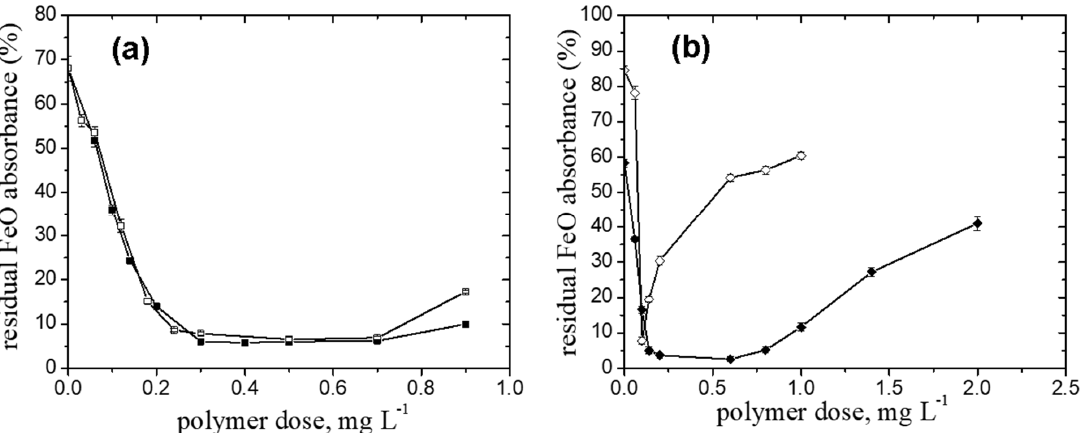
Figure 6. The residual FeO absorbance (%) dependence on the polymer dose: TMAP 0.4 –P for c ip = 0.1 g L − 1 (empty square) and c ip = 0.3 g L − 1 (solid square); c FeO = 0.4 g L − 1 ( a ) and TMAP 0.7 –P for c FeO = 0.2 g L − 1 (empty diamond) and c FeO = 0.6 g L − 1 (solid diamond); c ip = 1 g L − 1 ( b ); pH = 8.34, settling time 120 min.